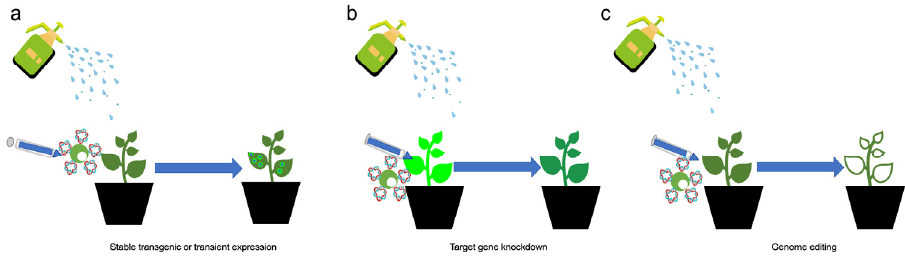
Figure 2. The application of nanomaterials in plant genetic engineering. By spraying, injection, and co-culturing cargo-packaged nanomaterials, plants can be engineered using stable integration or transient expression of exogenous genes ( a ), or by knockdown of target genes by delivering microRNAs ( b ), or by precise genome editing through the delivery of the CRISPR/Cas system ( c ). There have been reports in which magnetic particles are used as the vector to enter plant cells through larger pores such as pollen cells or protoplasts, and foreign genes are then expressed with the help of a magnetic field. FITC signals, which are delivered by PEG-modified magnetic gold particles (mGNPs, ~30 nm) have been observed in over 95% of canola protoplasts [71]. Plasmid with GUS gene bound with mGNPs were transferred into canola cells and GUS expression was detected after co-culturing for 48 h. In 2017, magnetic Fe 3 O 4 was decorated with branched polyethyleneimine (PEI) and introduced into pollen cells via the pollen aperture. This system was tested by GUS gene in many have been transferred in to cotton pollens. Transgenic plants were obtained and it was